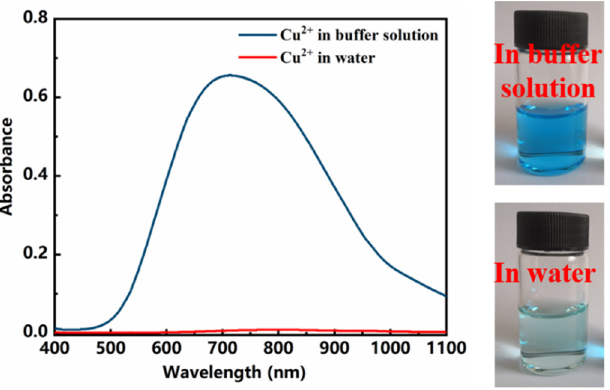
Figure 2. Absorption spectra for Cu 2+ in water and in buffer solution.